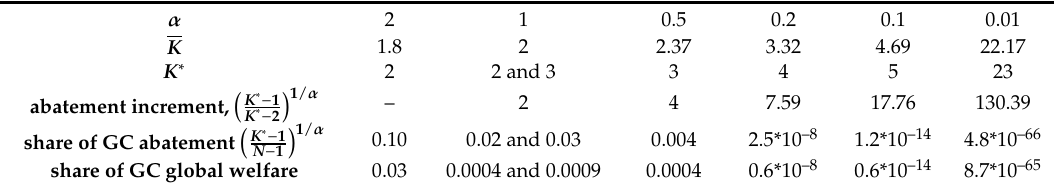
Table 1. Critical coalition sizes, stable coalitions, and their properties for di ff erent values of α . α